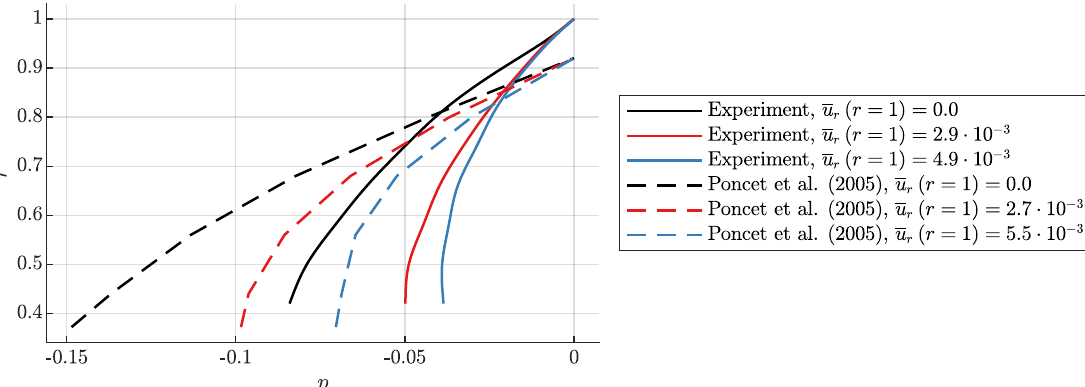
Figure 3. The radial distribution of pressure p with and without centrifugal through-flow at low Reynolds numbers. In the experiment, the cavity width G is 0.0375. Poncet et al. [4] use G = 0.0360.